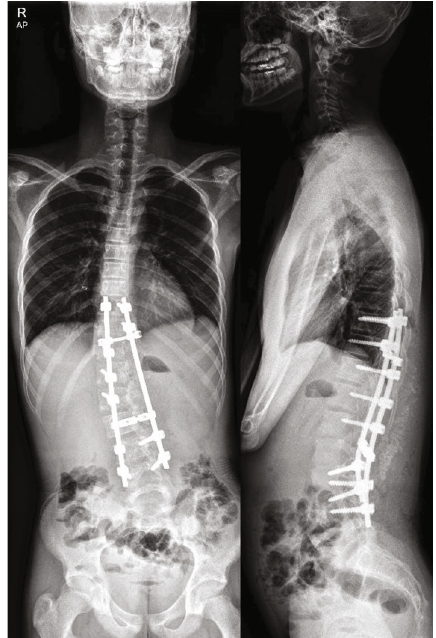
Figure 5: Whole spine plain radiograph. AP and lateral view at the immediate post-op, January 2 nd , 2016.